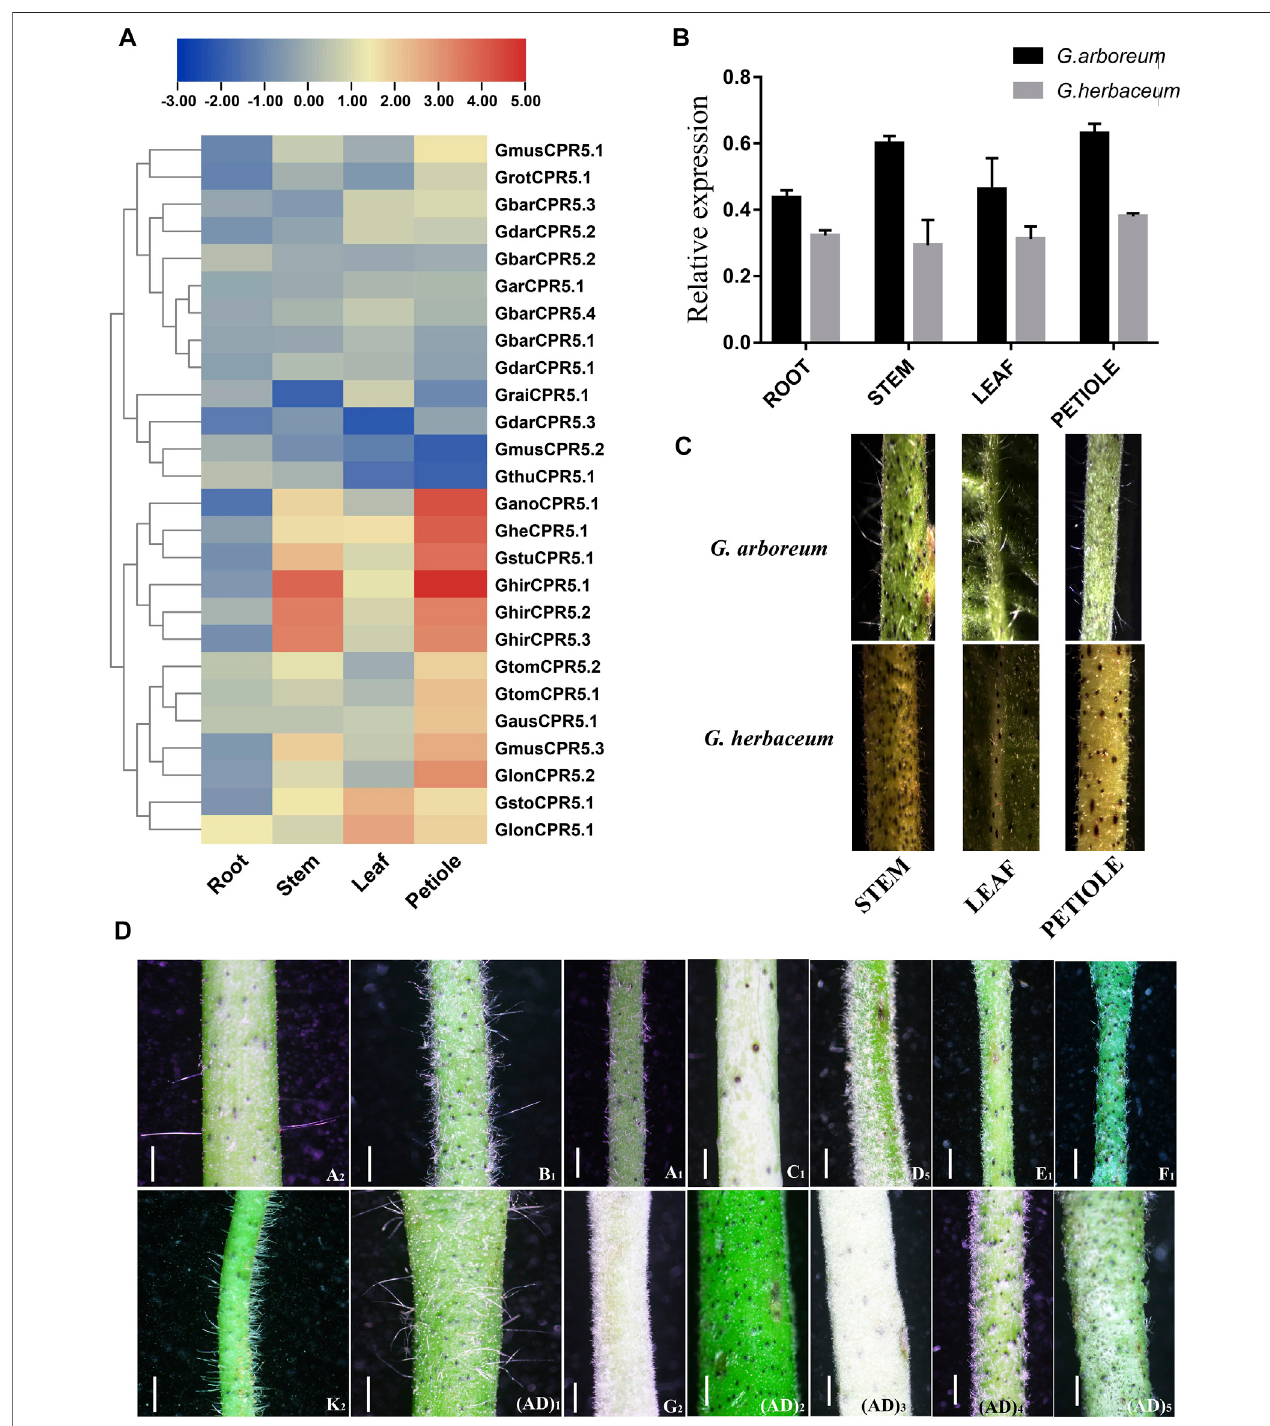
FIGURE 9 | Expression of CPR5 genes in different cotton species. (A)- Differential expression of all the CPR5 genes in roots, stem, leaves and petioles. (B)- Expression analysis of GheCPR5.1 in different tissues of G. arboretum and G. herbaceum . (C)- Density of trichomes in G. arboretum and G. herbaceum. (D)- Trichome density in all the Gossypium species used in this research work.